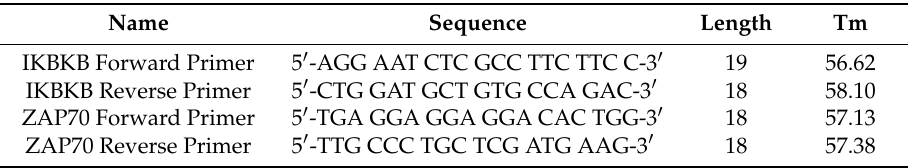
Table 1. Primer sequences and Tms for PCR